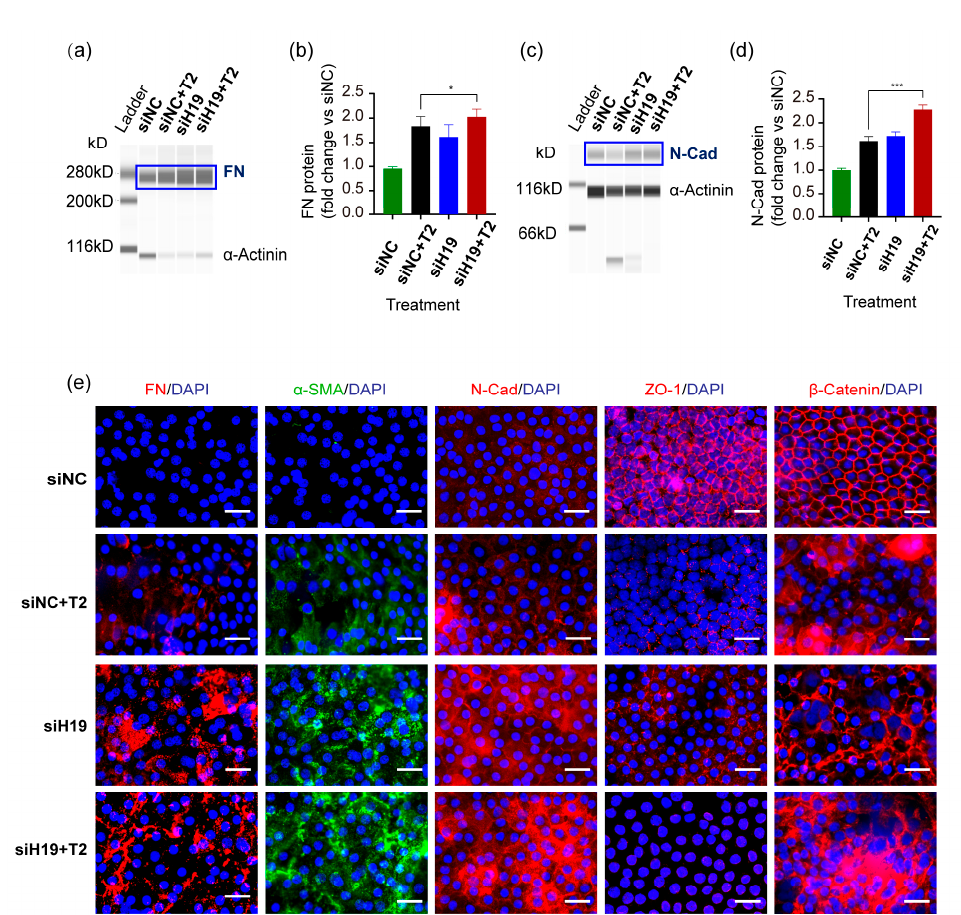
Figure 2. Knockdown of H19 in human lens epithelial cells in situ accelerated TGF- β 2-induced EMT. ( a – d ) After transfection with si H19 -002 for 24 h and further exposure to TGF- β 2 for 24 h, the Wes platform detected protein levels of mesenchymal markers FN and N-Cad in the human LEEs, which were further quantified using Image J. * p < 0.05, *** p < 0.001. ( e ) Fluorescent staining of FN, α -SMA, N-Cad, ZO-1, and β -catenin on human LEEs. Scale bars, 20 μ m.